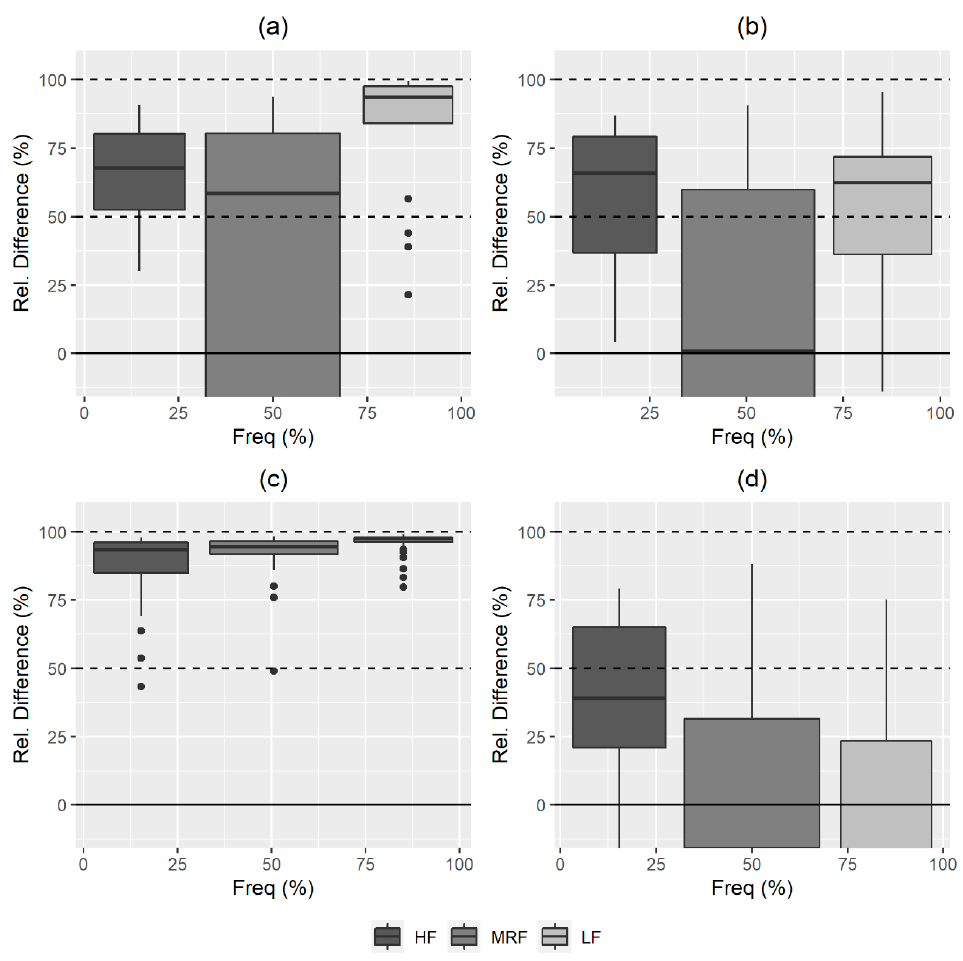
Figure 9. Percentage of reduction per class of flow for gauge ( a ) 56028000/RD001, ( b ) 56075000/RD007, ( c ) 56110005/RD013 and, ( d ) 56539000/RD023. : HF, high flows, MRF, Mid-range flows, LF, low-flows. ( c ) 56110005 / RD013 and, ( d ) 56539000 / RD023. HF, high flows, MRF, Mid-range flows, LF,